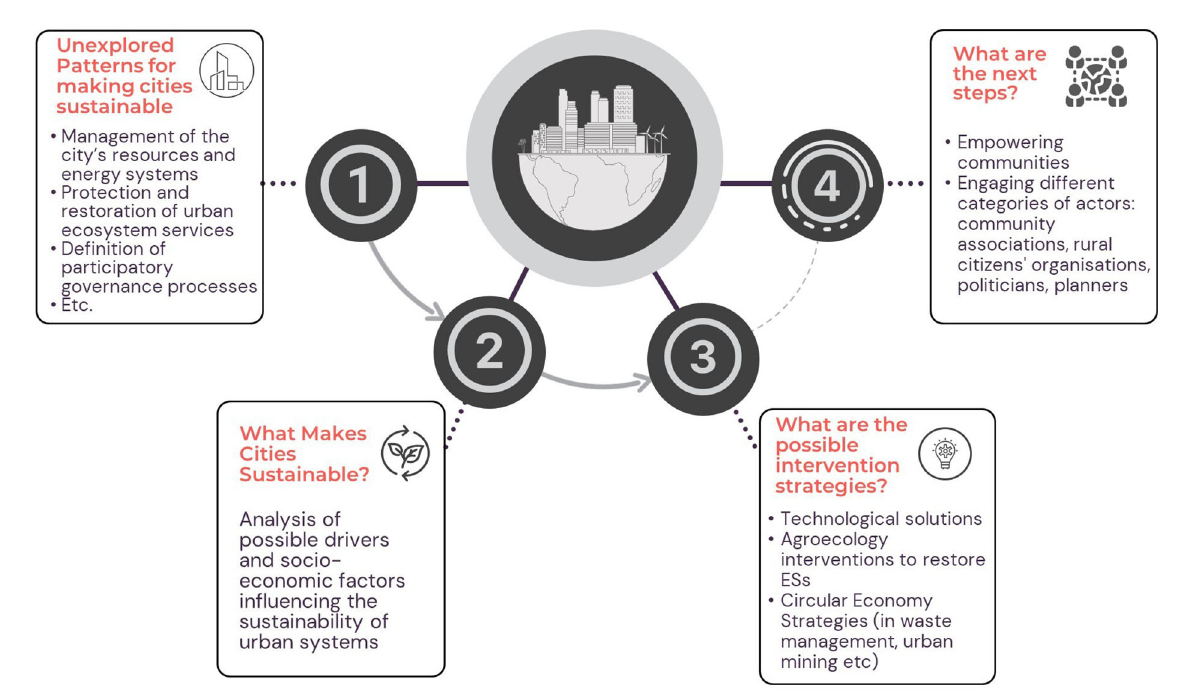
FIGURE1 Overview of Research Topic outcomes and future